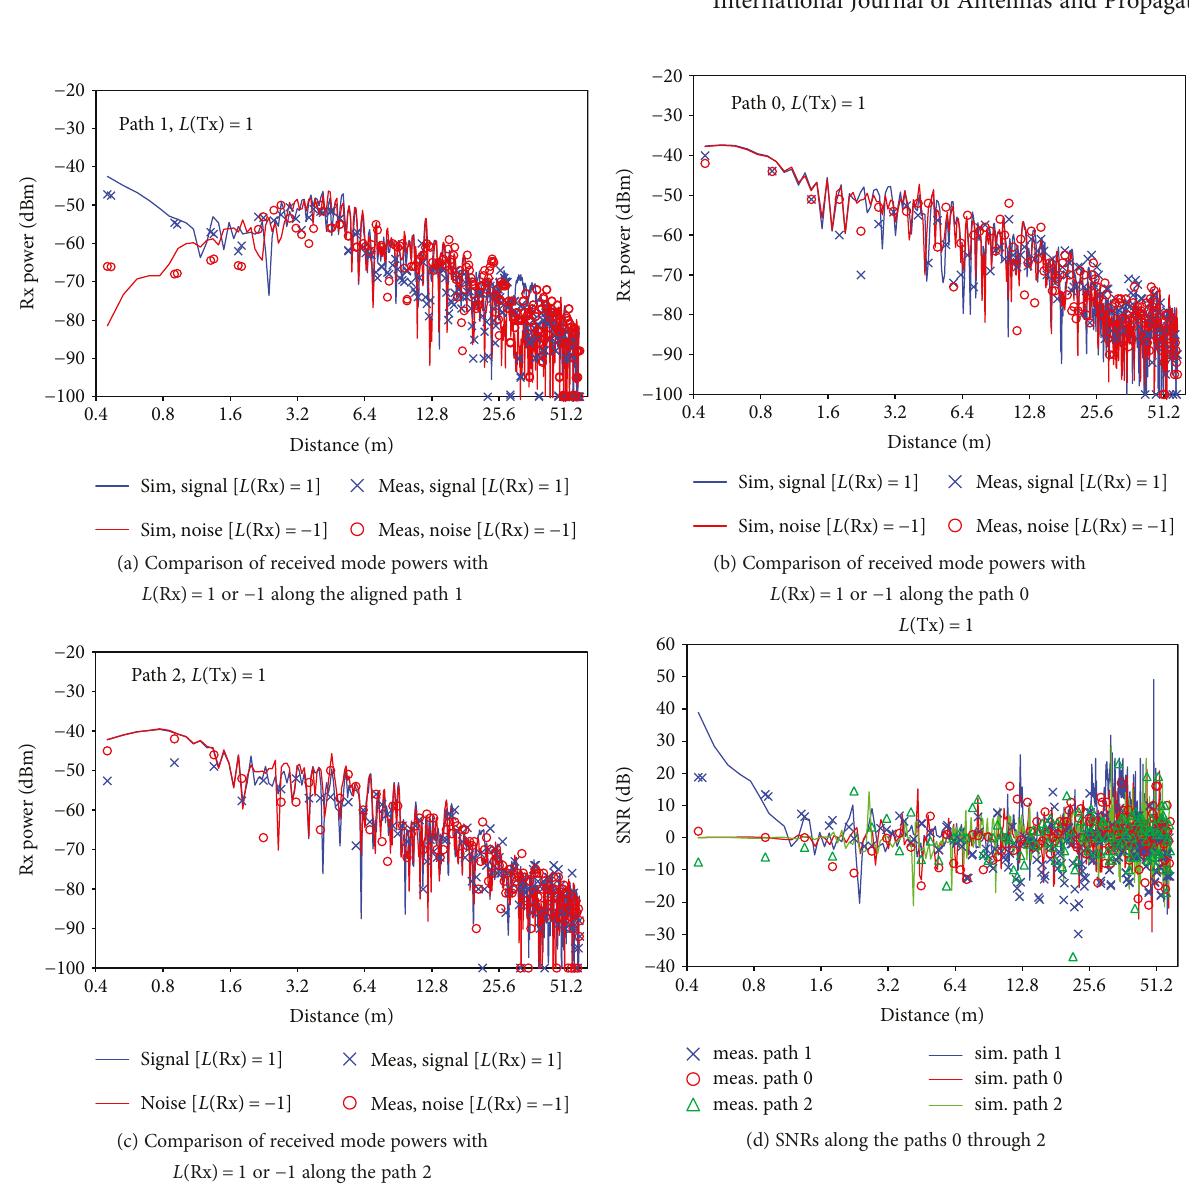
Figure 6: Received power levels of OAM modes for the transmitting mode of L =1 in the